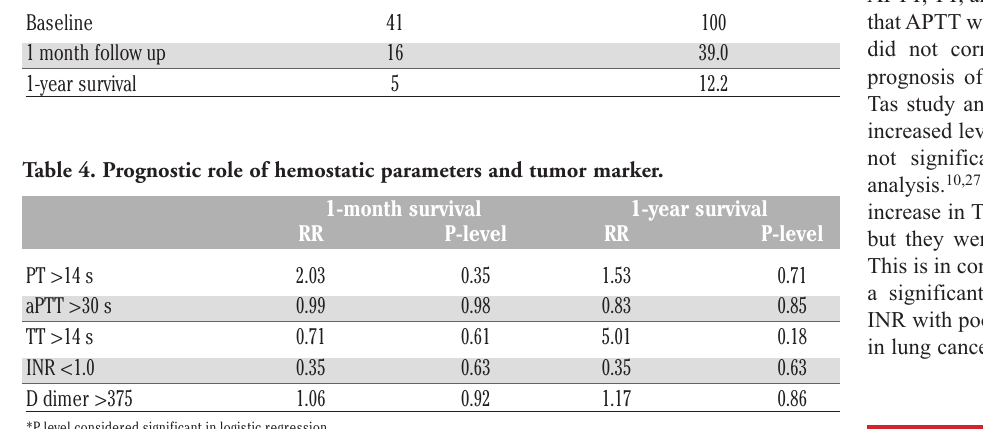
Table 3. One year follow up of NSCLC. Survival rate